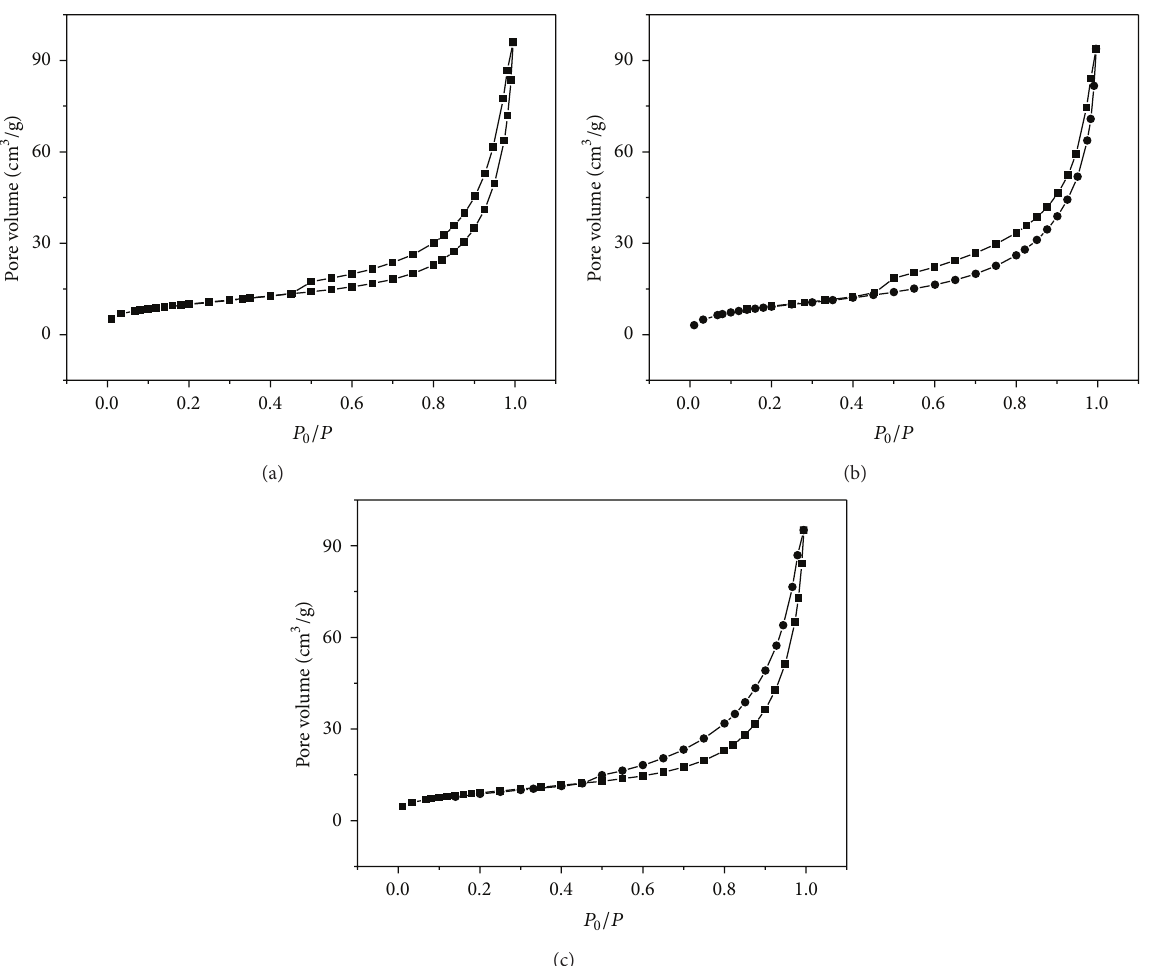
Figure 6: N 2 adsorption-desorption isothermal curves of CdIn 2 S 4 prepared at different temperatures (a) 500 ∘ C, (b) 600 ∘ C, and (c) 700 ∘ C.